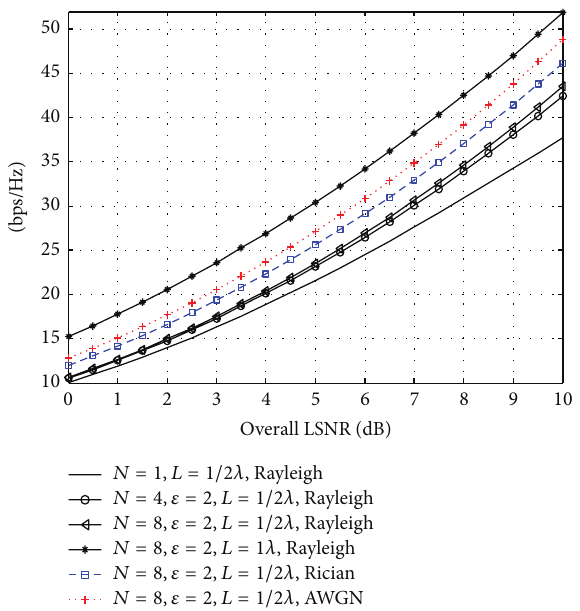
Figure 12: The normalized channel capacity for PULA with beam-